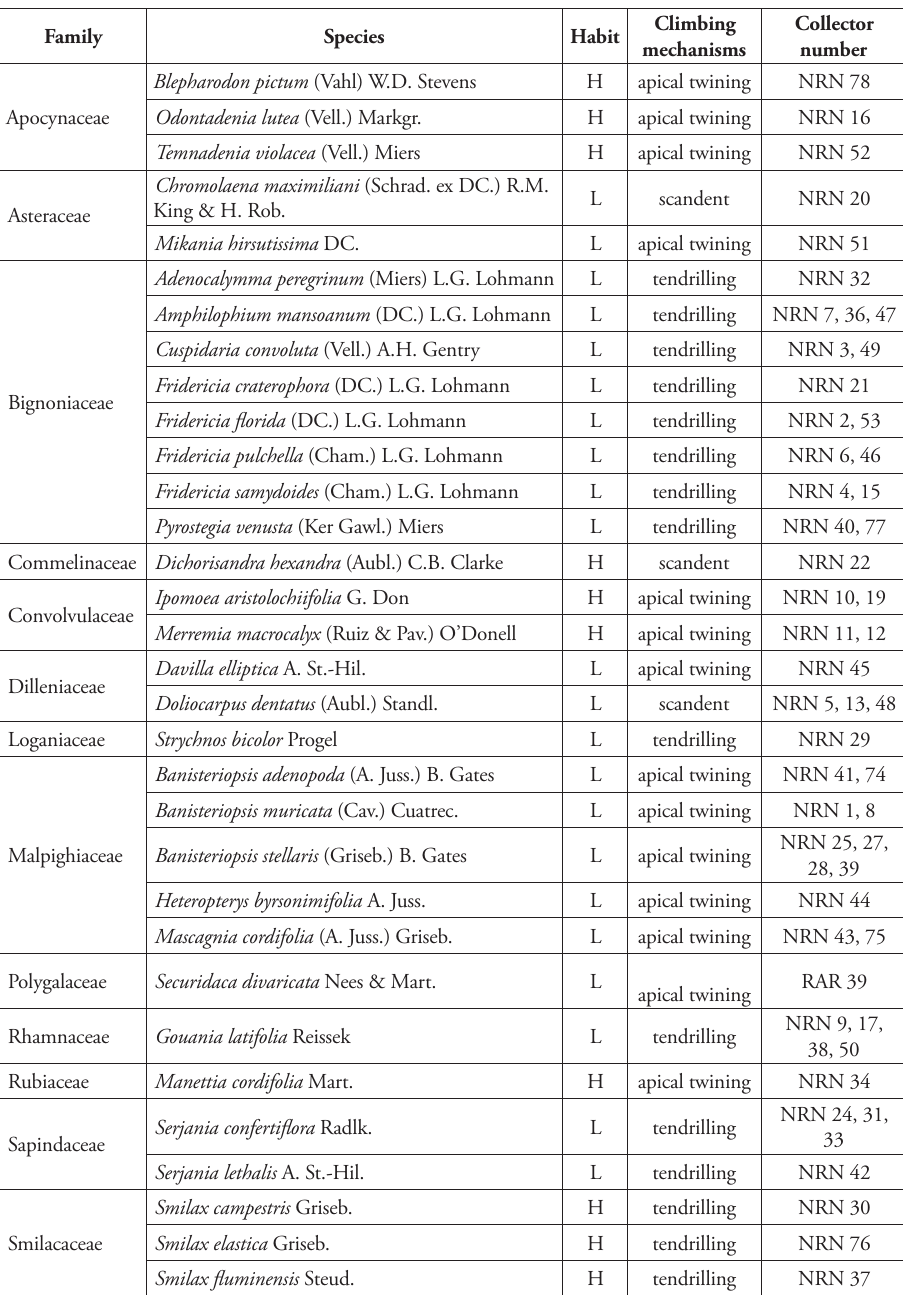
Table 1. Climbers from the Estação Ecológica de Assis (SP, Brazil). Habit (H = herbaceous; L = woody), climbing mechanisms and voucher information (collector: Nicácio Ribeiro Neto, NRN; Raquel Apare- cida Ronqui,